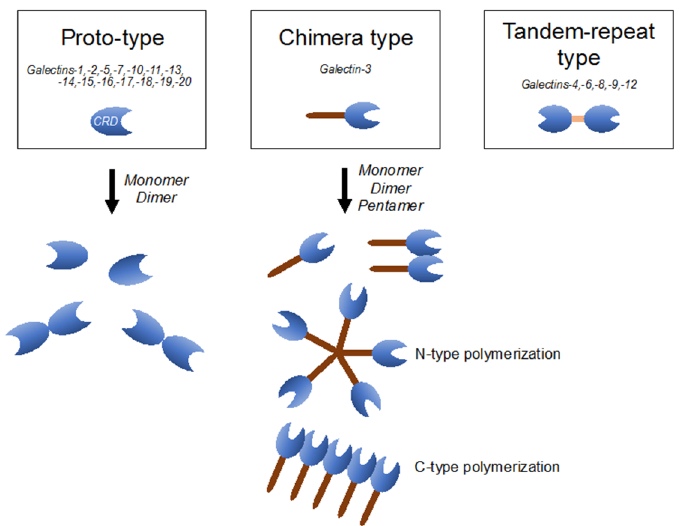
Figure 1. Classification of the galectin family is defined according to the respective carbohydrate- recognition domain (CRD) structure. Proto-type one consists of monomers or homodimers with one CRD; chimera-type one has a long non-lectin domain and one CRD; and tandem-repeat type one contains two distinct CRDs.